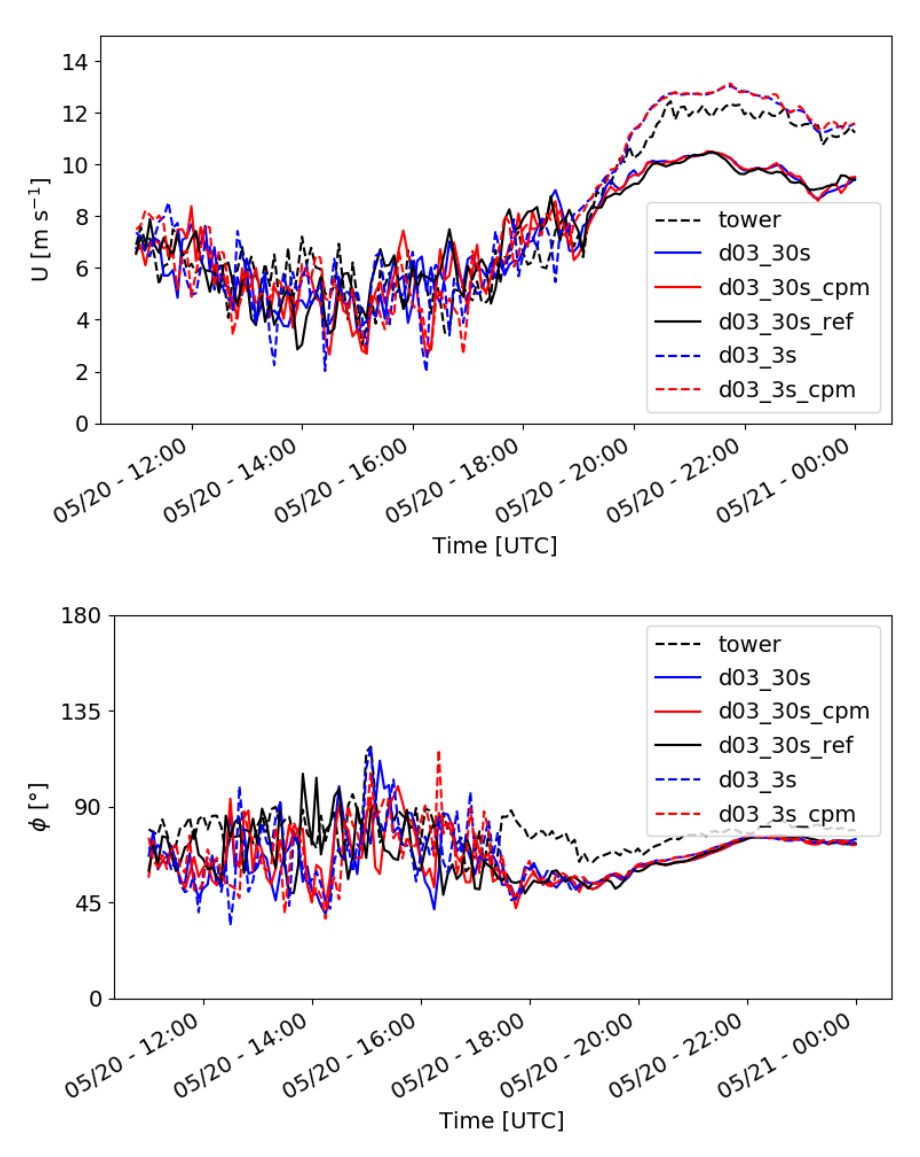
Figure 4. Wind speed ( top ), and wind direction ( bottom ) time series from 100 m a.g.l. at a tower, tse04, on the ridge of the Vale do